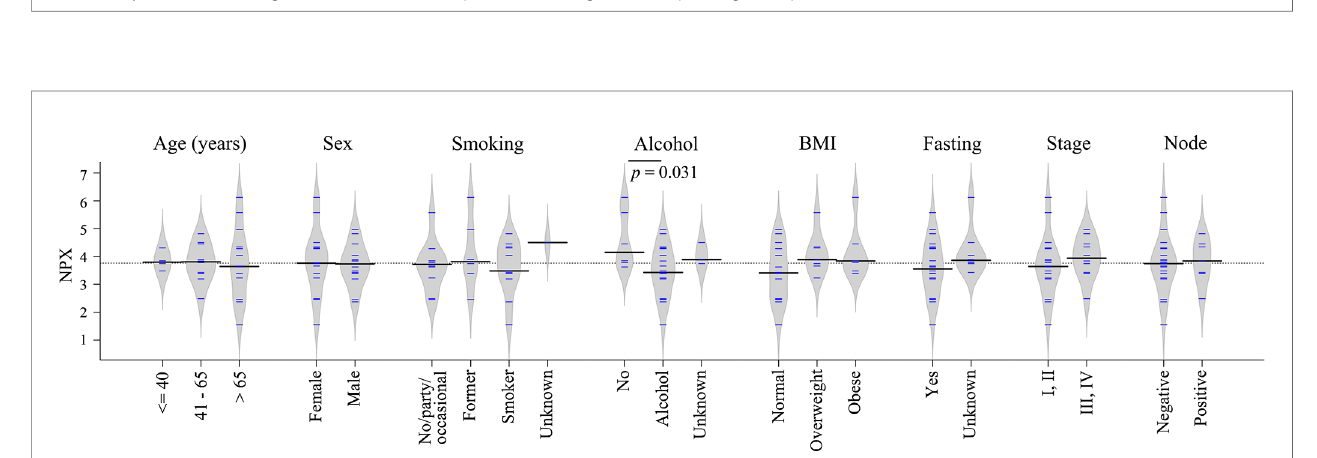
FIGURE 5 | Bar chart showing TRAF2 levels in the fi ve patients with diagnostic and pre-diagnostic plasma.